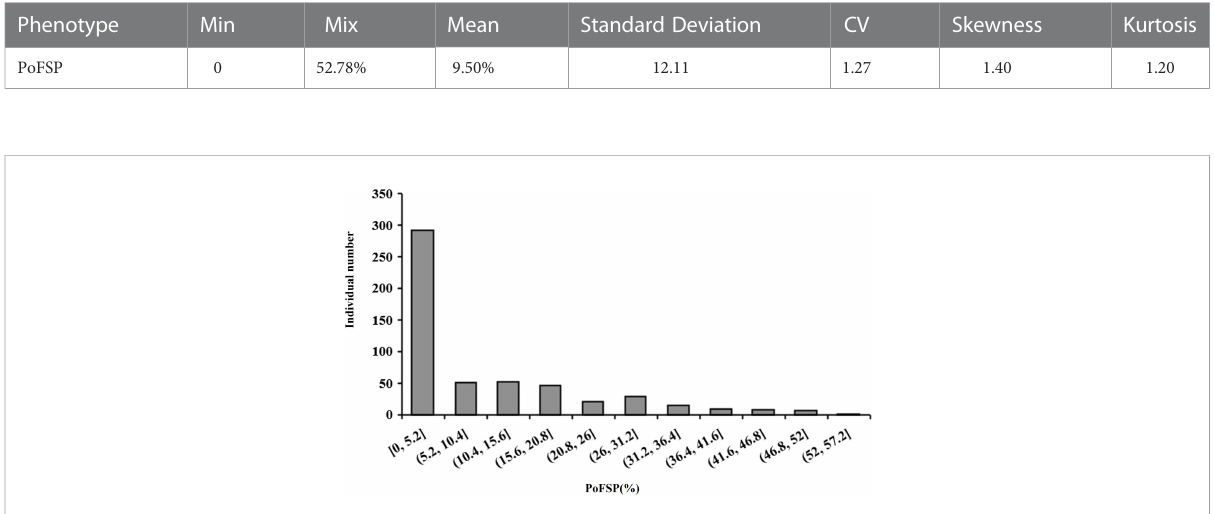
FIGURE 11 Frequency histogram of the phenotypic distribution of PoFSP in the resource